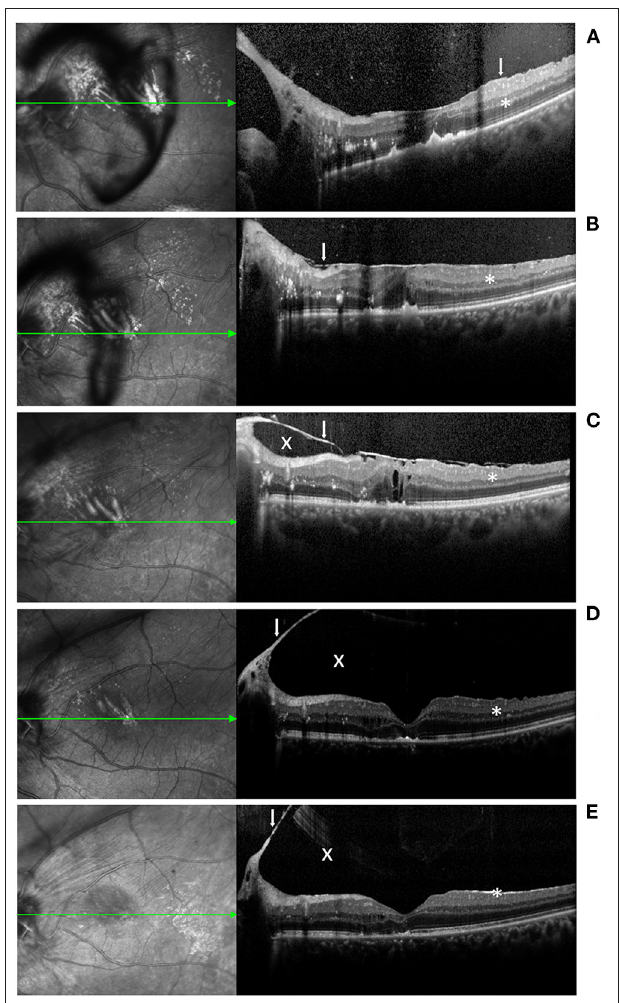
FIGURE 4 | Macular OCT imaging before and after LP in the left eye. (A,B) At 2 weeks and 1 month after the first round of LP, ERM exacerbation (white arrow) and adherence to the retina (*) were observed. (C) At 1 month after the second round of LP, the ERM persisted and cystoid macular edema was observed. A cavity appeared between the ERM and retina. (D,E) At 5 months and 1 year after the second round of LP, the ERM separated spontaneously concomitant with PVD. The inner segment/outer segment layer was partially defected in the